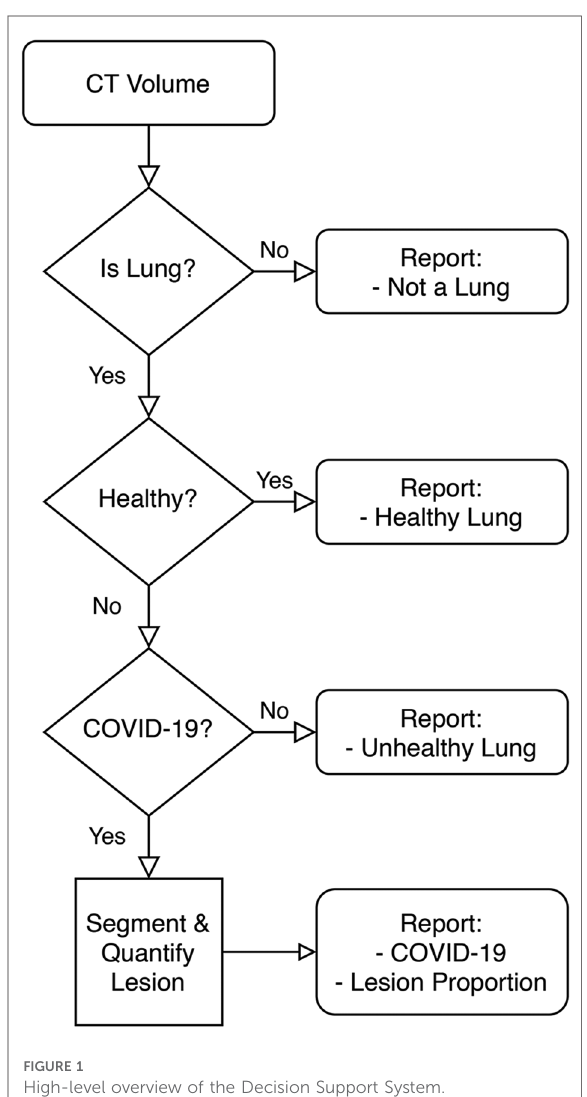
FIGURE 1 High-level overview of the Decision Support